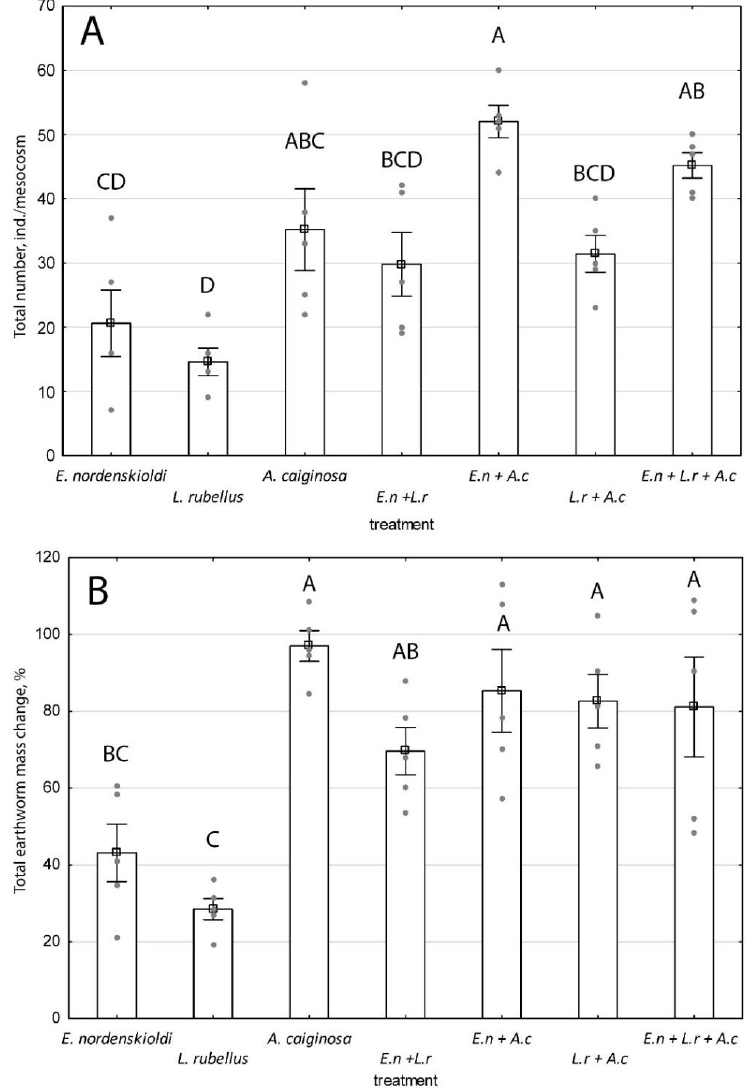
Figure 2. Total number and biomass of earthworms in different variants of the vegetation experi- ment in mesocosms (mean ± SE, raw data), ( A ) numbers, individuals/vessel, ( B ) biomass, % of starting values. Variants with different letters show significant differences (α = 0.05 Tukey HSD).